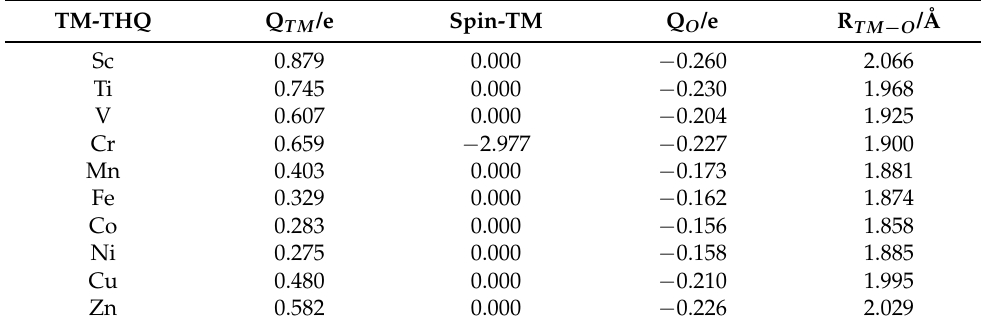
Table 1. Hirshfeld charges on the metal atom Q T M and oxygen atom Q O of the 10 TM-THQ system, the spin of the metal atom and the length of the